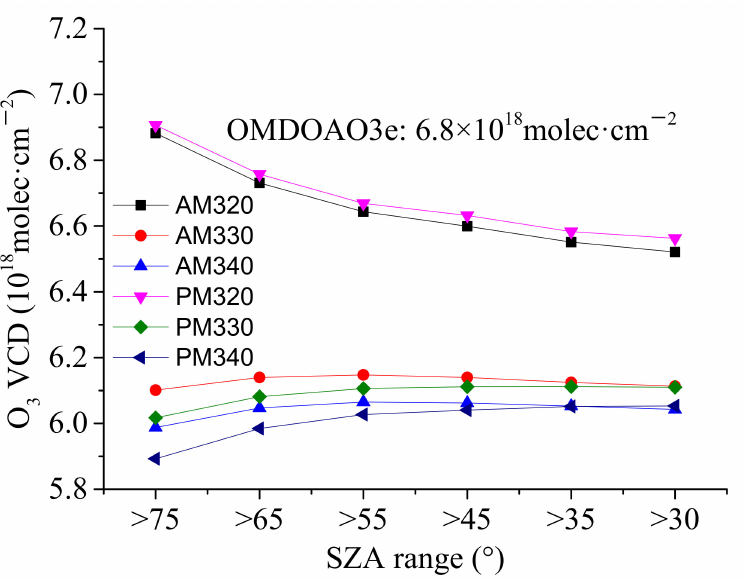
Figure 5. O 3 VCDs derived from the Langley plot method for different SZA ranges and simulation wavelengths during ante meridiem (AM) and post meridiem (PM), corresponding to the sunrise and sunset. The value of 6.8 × 10 18 molec · cm − 2 given in the figure represents the O 3 VCD derived from OMI (OMDOAO3e) on the selected day (30 August 2020).